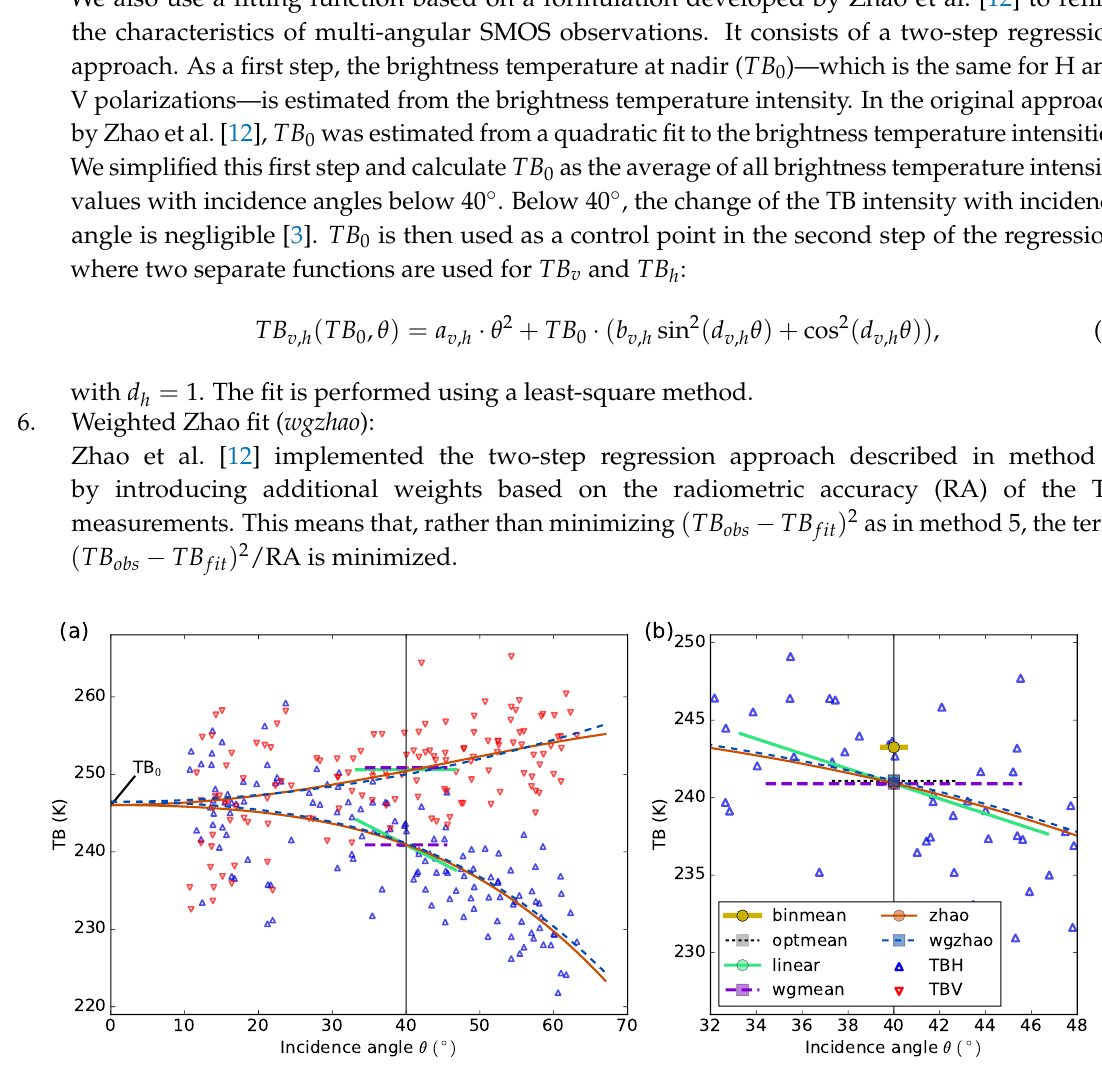
Figure 3. Example of polarized brightness temperatures as function of incidence angle over sea ice on 5 March 2015. The different fitting methods for θ 0 = 40 ◦ are illustrated by the different lines. ( b ) is a zoom into ( a ) for horizontal